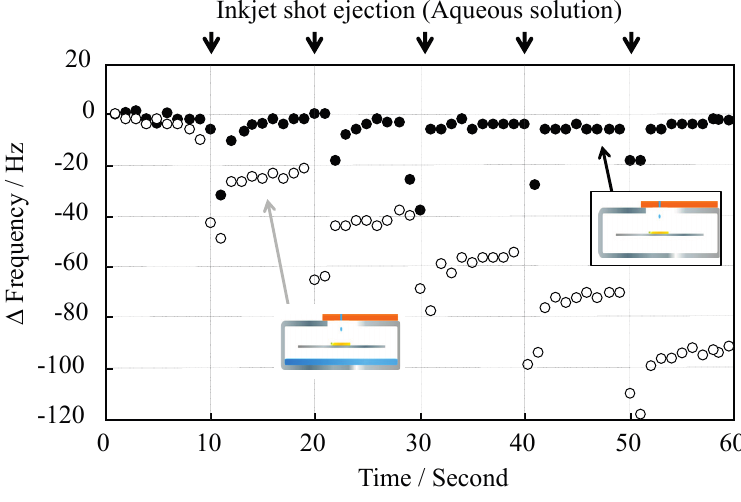
Figure 3. Variation in QCM frequency during 10-shot inkjet injections in a stainless-steel cover, with ( ○ ) and without ( ● ) added water. Frequency changes were examined to evaluate the effect of the humidifying